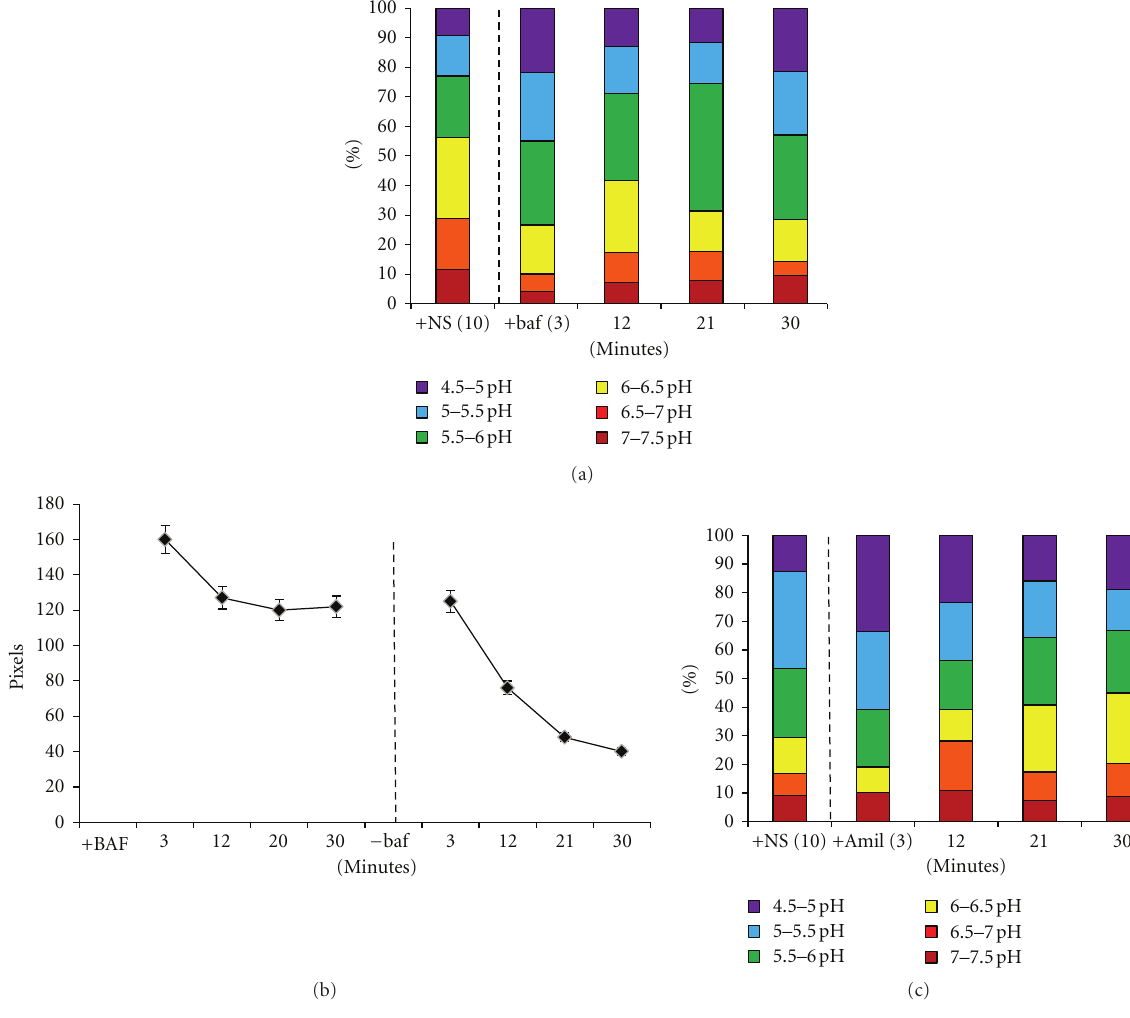
Figure 9: Nanosensor recovery from pharmacological treatment. (a) Representation of cells incubated at 37 ◦ C with nanosensor addition and incubation for ten minutes. The first bar of the graph is representative of nanosensors inside cells without chemical addition. After the dashed line, the bar graph is representative to nanosensor ph after the addition of bafilomycin to the cells. (b) Total pixel/nanosensor count within cells. Time points after dashed line are representative to the removal of bafilomycin and addition of fresh media. (c) Representation of nanosensor pH in cells incubated at 37 ◦ C with nanosensor incubation for ten minutes followed by the addition of amiloride. The first bar of the graph is cells incubated with nanosensors for ten minutes. The data after the dashed line is the addition of amiloride to the media followed by imaging at respective time points. Reprinted with permission from Nowak-Lovato et al. [11] (copyright 2010